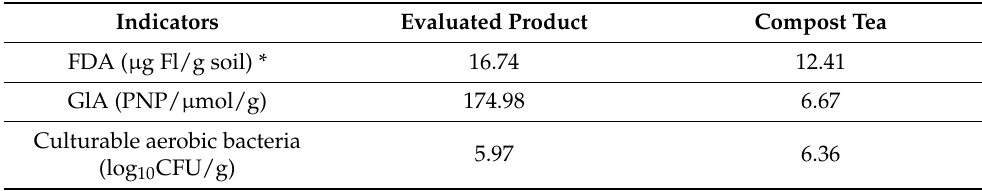
Table 4. Microbiological characteristics of evaluated product and compost